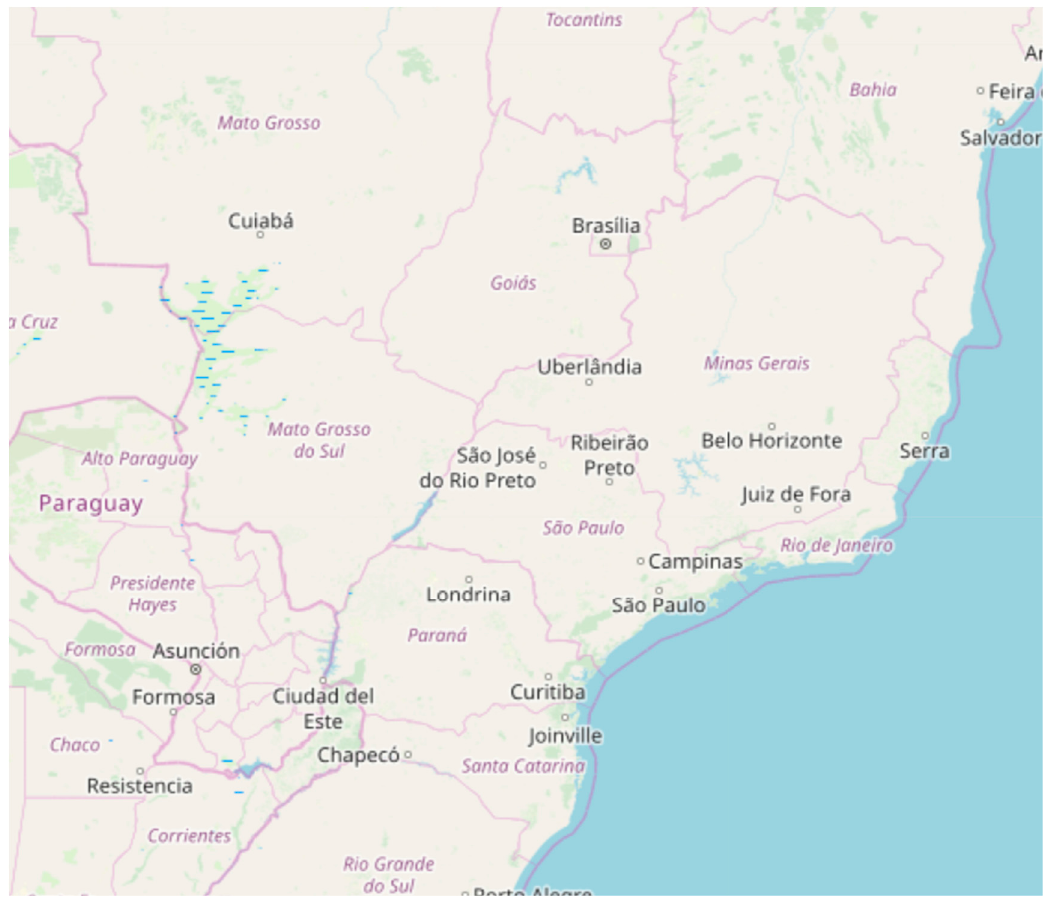
Figure 5. Map showing the location of the city of Belo Horizonte, Bra zil. © OpenStreetMap